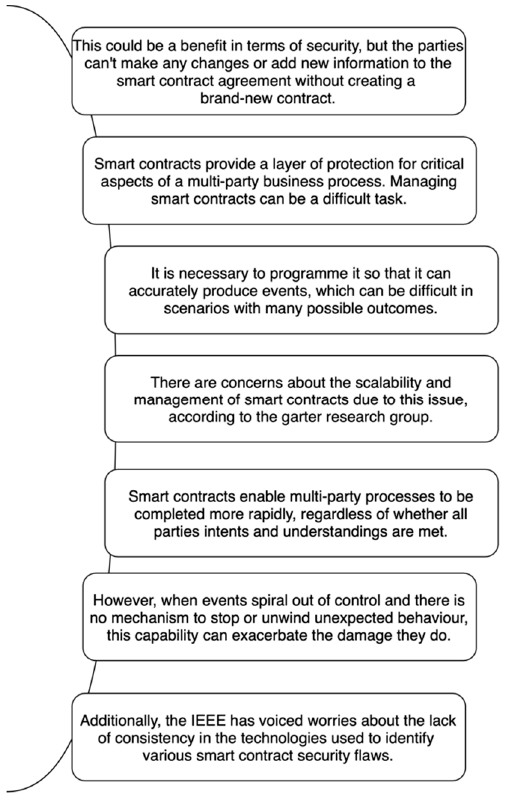
Figure 5. Common Issues and Challenges with Smart